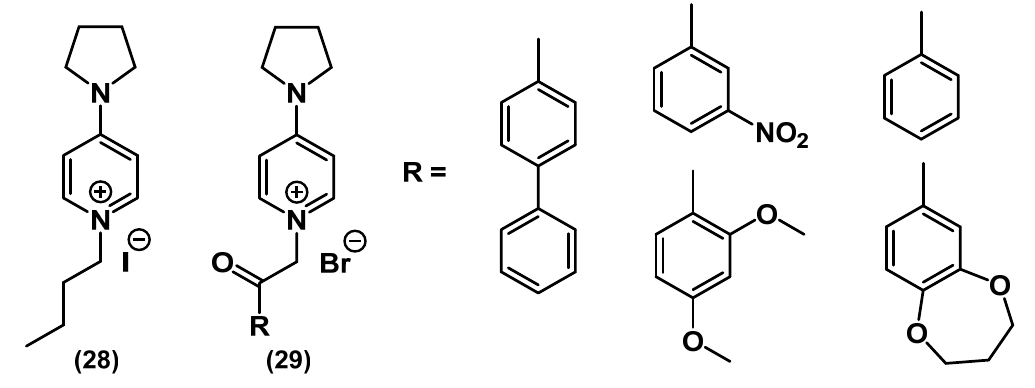
Figure 14. Mono-QACs containing aryl